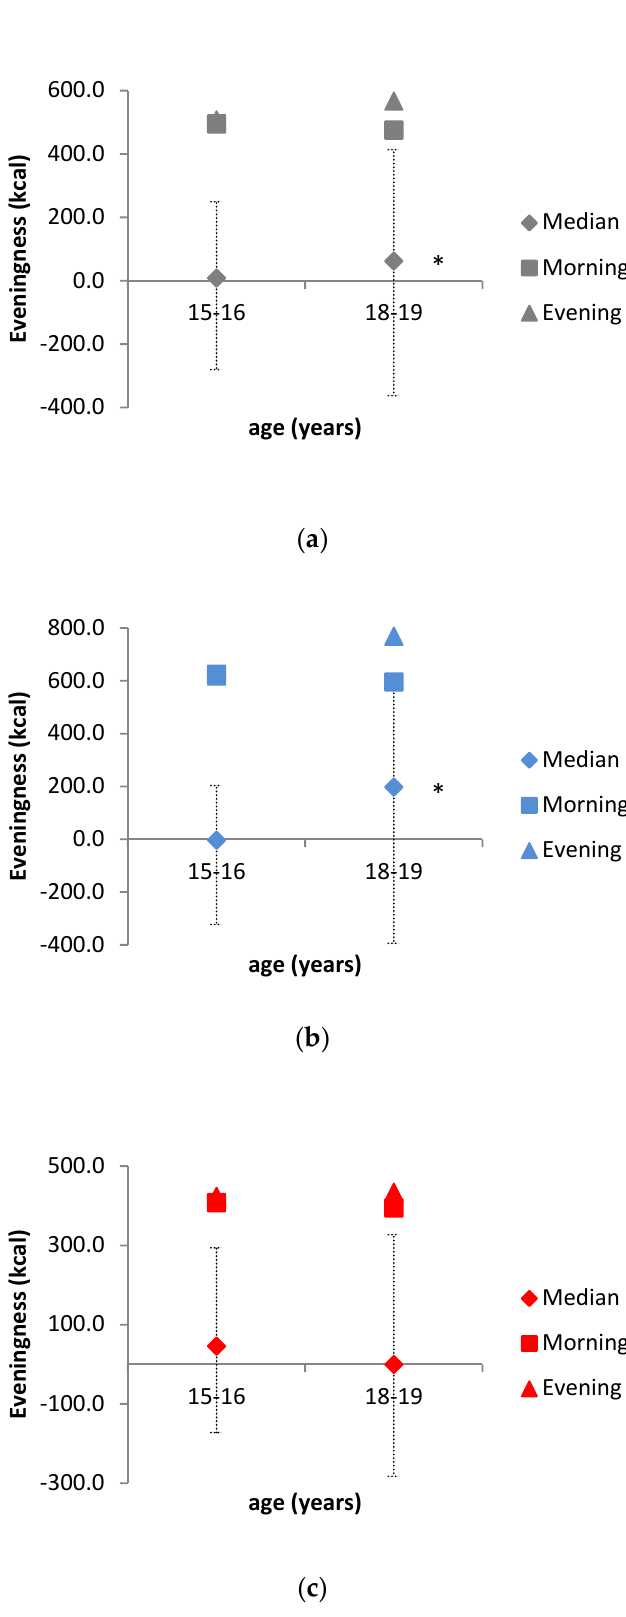
Figure 2. Eveningness in energy intake presented as the difference between evening and morning energy intake. ♦ Shows 50th percentile, while dotted lines represent range from 25th to 75th percentile. ■ indicates morning energy intake and ▲ represents evening energy intake. * represents a statistically significant difference between the age of 15/16 and 18/19 ( p < 0.05): ( a ) whole population; ( b ) male population; ( c ) female population.